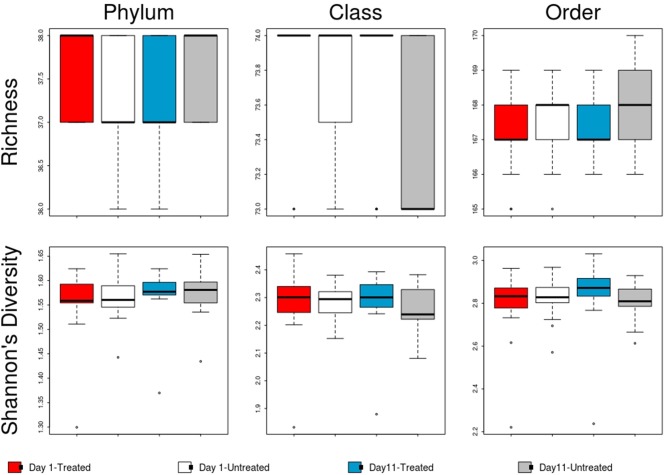
Boxplot of microbiome richness and Shannon's diversity at the phylum, class and order levels of the two study groups at Day 1 and Day 11. The horizontal line is the median value, the middle box indicates the inter-quantile range, whiskers represent values within 1.5 IQR of the lower and upper quartiles, and individual points show outlier values.